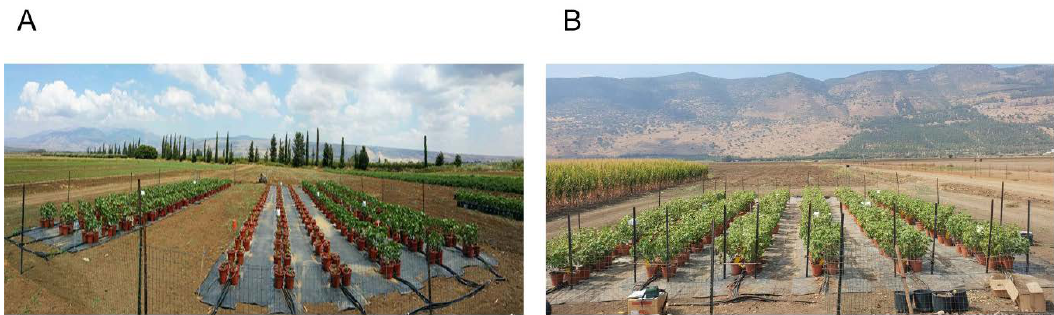
Figure 1. Setup of experiments in Gadash Farm, Hula Valley, Israel. ( A ) and ( B ) represent the plant pot experiments during 2018 and 2019, respectively.